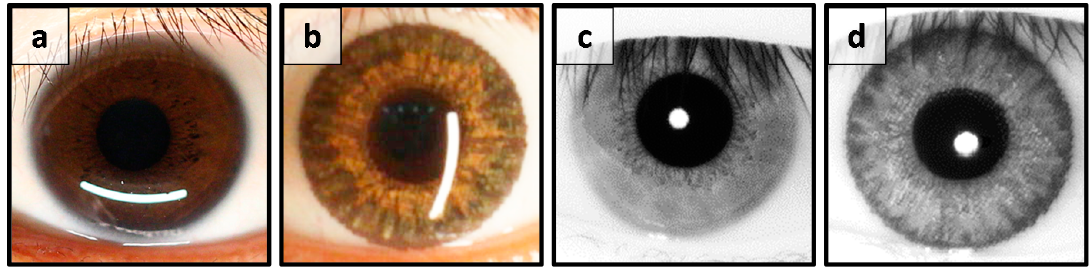
Figure 1. Images of same eye with and without CCL; ( a , b ) captured by color sensor and ( c , d ) monochromatic sensor; ( a , c ) naked eye and ( b , d ) with